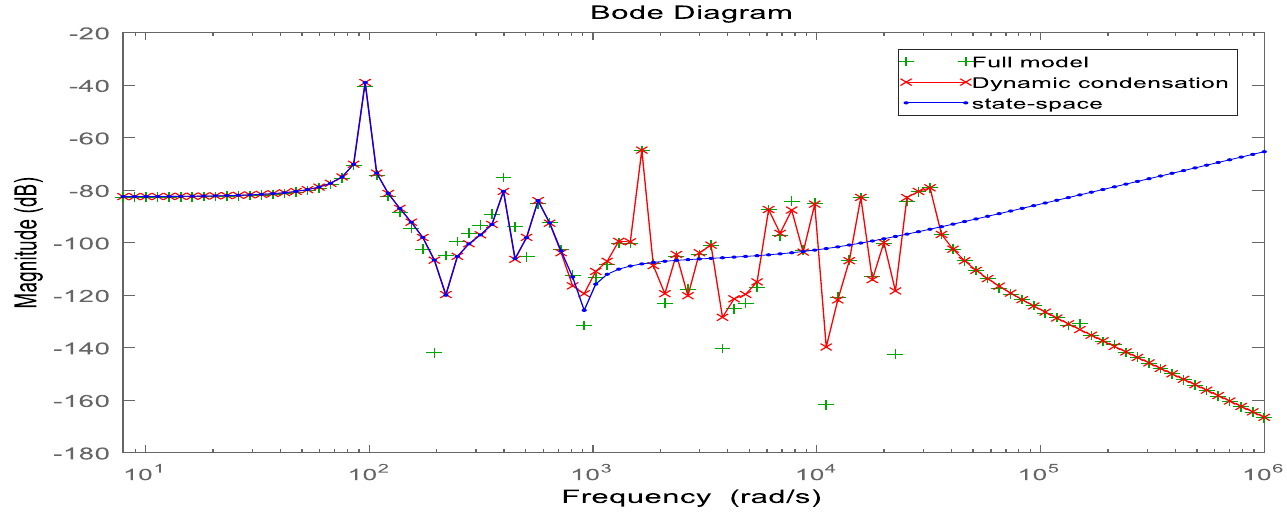
Figure 6. Bode diagram in the frequency domain before and after model reduction.